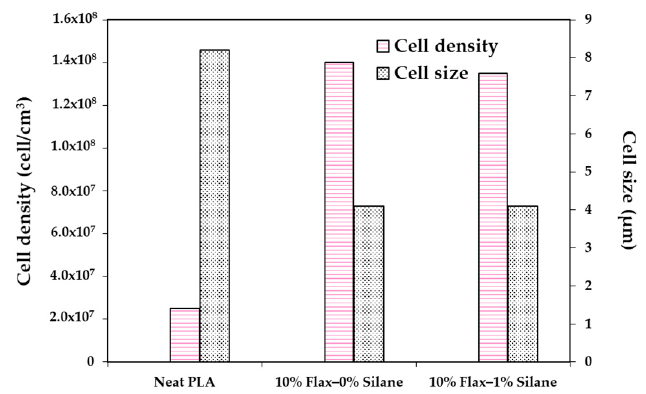
Figure 25. Average cell size and cell density of microcellular PLA and PLA-flax fiber composites. Data taken from Pilla et al. [105].